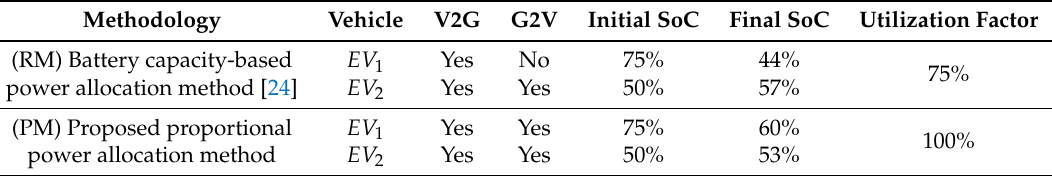
Table 4. EV power allocation method comparison.